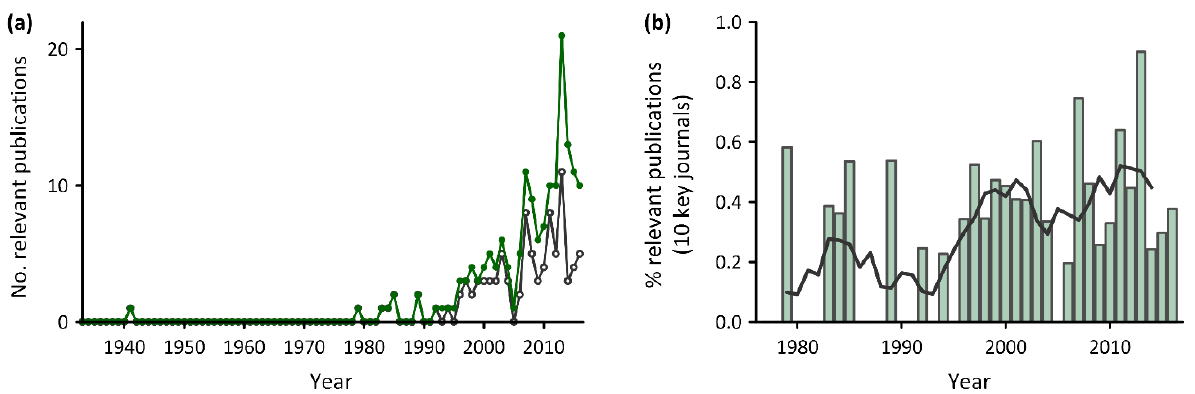
Figure 3. Temporal trends in publications relevant to the Peatland Evidence Synthesis (i.e. quantitatively reporting the effects of conservation interventions on peatland vegetation). Panel (a) shows the total number of relevant publications (green filled circles) and the total number of relevant publications from 10 key journals (black open circles) since the earliest journal issue searched (1933). Panel (b) shows the percentage of all publications in the 10 key journals that were relevant to the synthesis (green bars), with a five-year moving average (black line), since 1979. The ten key journals were those that contributed the most publications to the synthesis (see Methods).